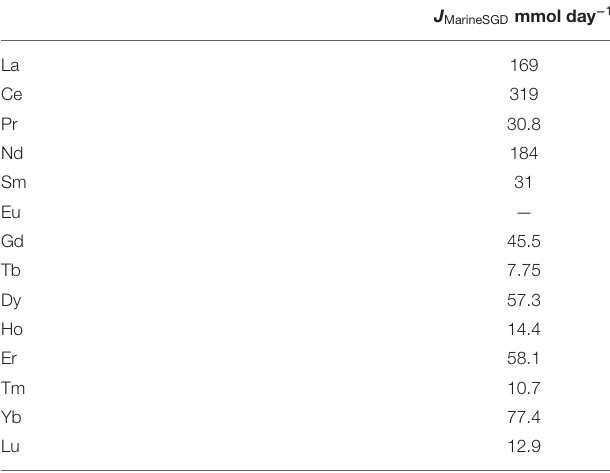
The flux computed for each REE represents the integrated flux estimated across the 3km offshore transect in µ mol day − 1 per m of shoreline multiplied by the 5.88km distance between theEauGallieRiverand CraneCreek( Figure 1B ). Abootstrapanalysis of the integrated fluxes indicates errors for J MarineSGD for each REE of ± 5%. See Supplementary Material for more